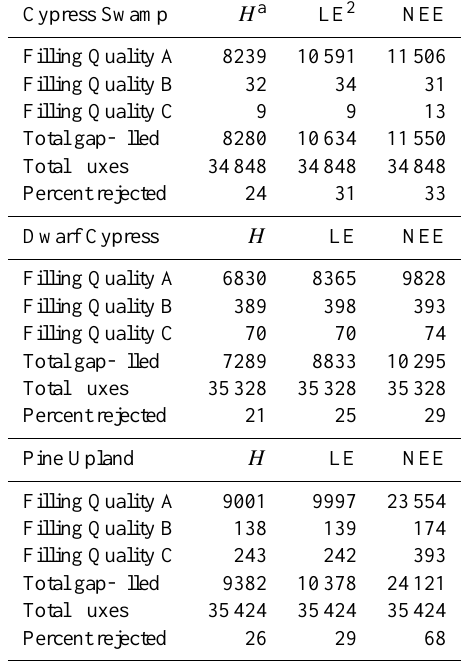
Table 3. Gap-filling results for fluxes based on the lookup table ap- proach by Reichstein et al. (2005).